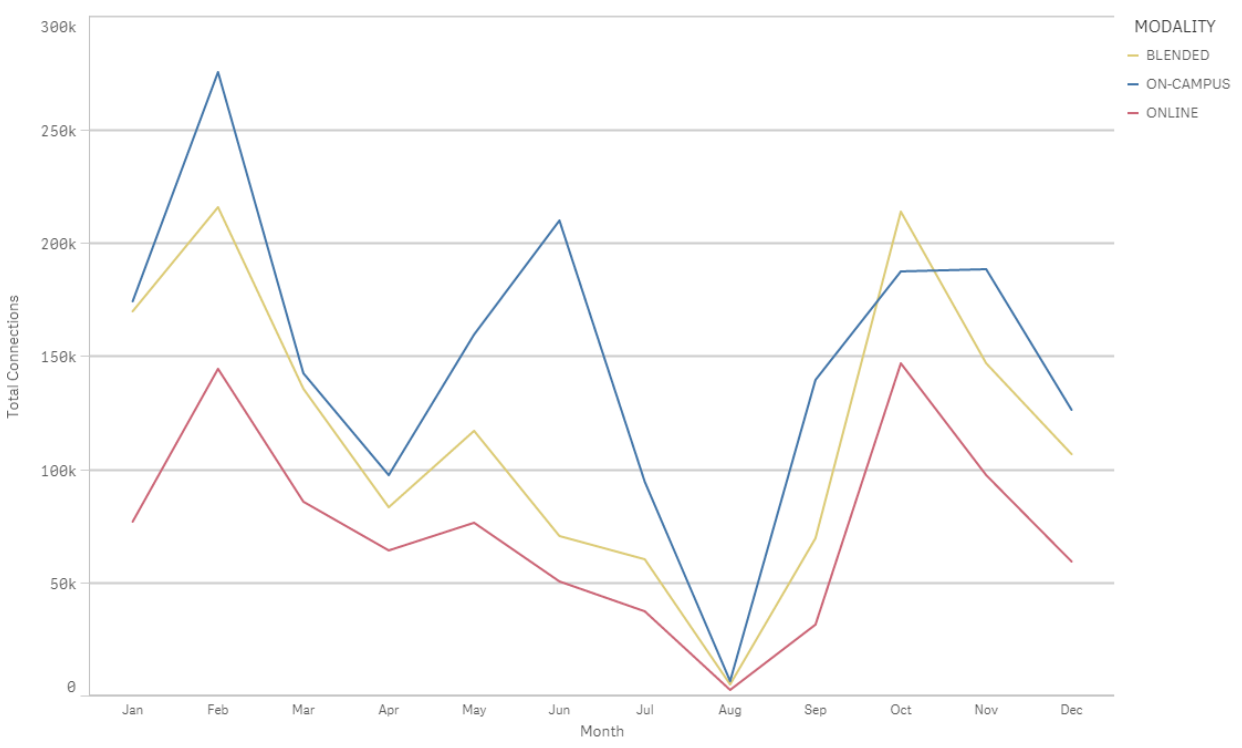
Figure 5. Annual trend in lecturers’ log-ins for each training